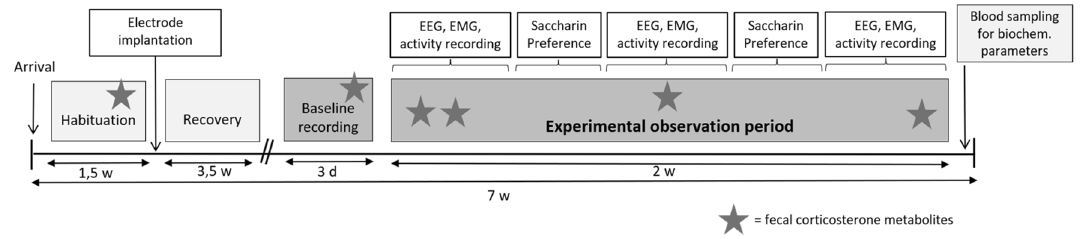
Figure 1. Timeline of the study. EEG: electroencephalographic; EMG: